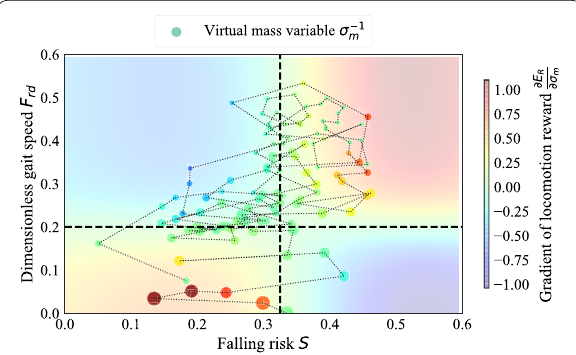
Fig. 11 Verification of behavior of VM-SAL the plotted data has the size based on σ − 1 m and the color based on the change of σ m ; in the region 4 with above-average speed and high falling risk (i.e., when initial stage in the obstacles area), σ m became large to easily decelerate for stability; in the middle of and after the obstacles area, excess increase of σ m was restrained due to above-average speed and low falling risk (i.e., in the region